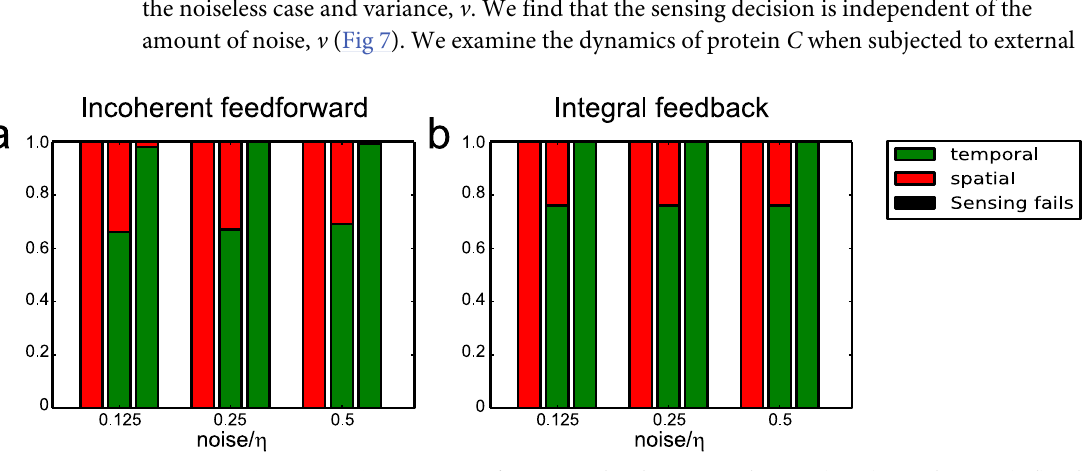
Fig 6. Noise in the external chemoattractant favors temporal sensing. Results for the incoherent feedforward circuit (left) and negative integral feedback circuit (right). (a) Fraction of parameters that yielded O amount of noise, η , for β = 0.25 (circle), β = 1.0 (diamonds) and β = 4.0 (triangles). (b) Fraction of parameters that chose temporal sensing (green), spatial sensing (red) and failure in sensing (black) at different amount of noise for β = 0.25 (first column), β = 1.0 (second column) and β = 4.0 (third column).